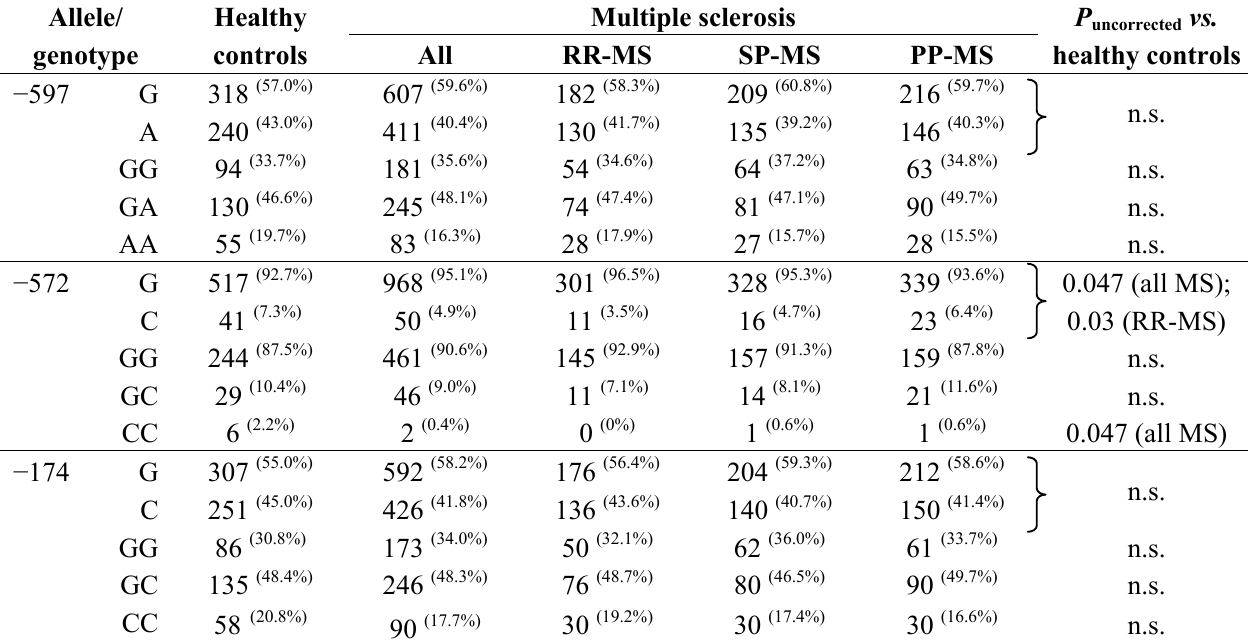
Table 2. Results of allelic and genotypic tests for the IL6 promoter polymorphisms.